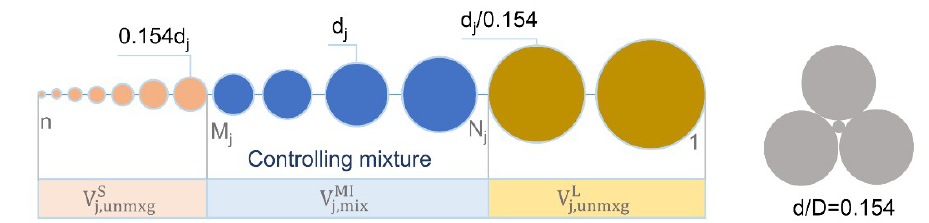
Figure 5. Classifying the mixture to partial specific volumes for diameter d j.